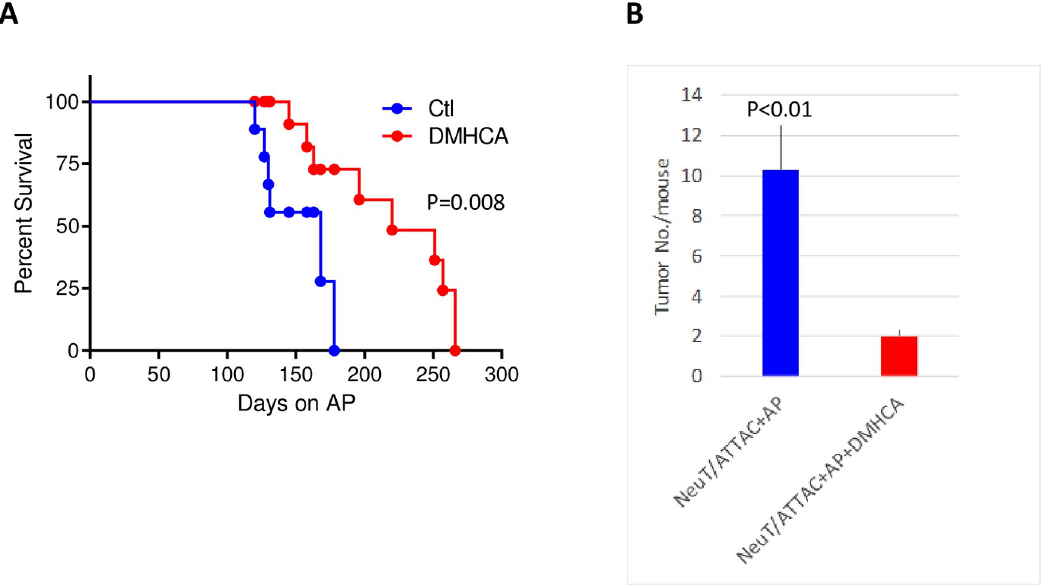
Fig 1. DMHCA reduced tumor progression and tumor multiplicity. Fibrosis was induced by i.p. injection of 0.4 mg/kg AP three times weekly beginning at 6 weeks of age and throughout the interval noted (‘Days on AP’). Beginning at 8 weeks of age, animals were administered a diet containing 0.05% DMHCA (100 mg/kg) until tumors appeared. A , Survival analysis of tumor progression following DMHCA treatment of NeuT/ATTAC+AP mice. Statistical significance was determined by the log rank Mantel-Cox test. B , Tumor multiplicity following DMHCA treatment. Statistical significance was determined by the two-tailed t